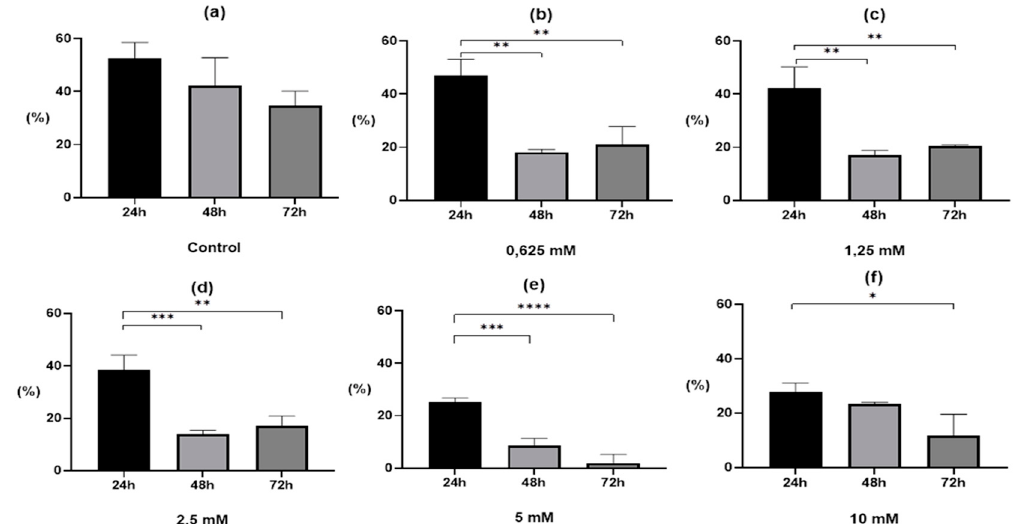
Figure 2. Percentage of invasive larvae (L 2 ) depending on the time of S-M-(-2MKA-BZ-5)TS exposure at individual drug concentrations: ( a ) Control — 0.1% DMSO; ( b ) 0.625 mM; ( c ) 1.25 mM; ( d ) 2.5 mM; ( e ) 5 mM; (f) 10 mM. Notes: * significant difference at p < 0.05; ** significant difference at p < 0.01; *** significant difference at p < 0.001; **** significant difference at p < 0.0001.